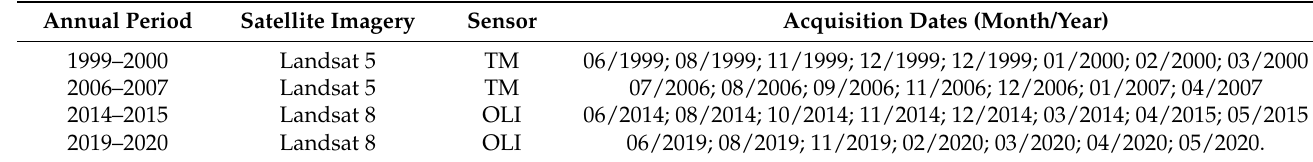
Table A1. Landsat images used for